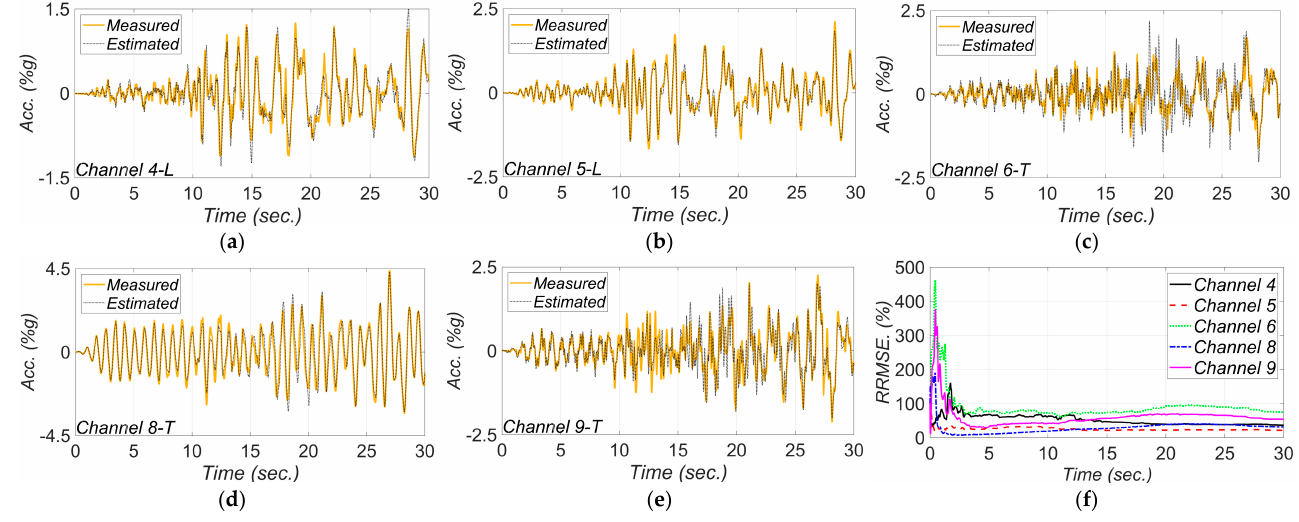
Figure 17. Comparison between measured and estimated (from updated model) responses at different measurement channels for 2003 San Simeon earthquake: ( a ) channel 4, ( b ) channel 5, ( c ) channel 6, ( d ) channel 8, ( e ) channel 9. Part ( f ) is the corresponding RRMSEs.